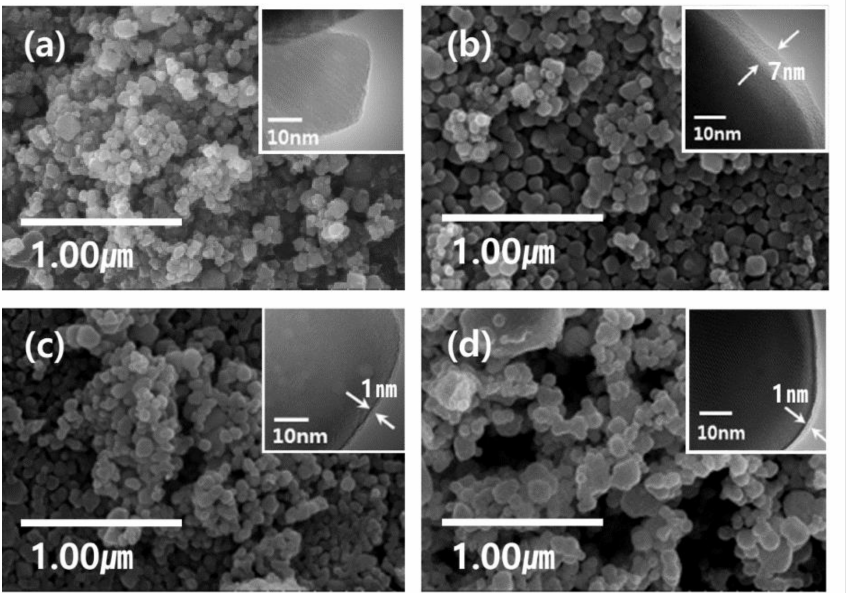
Figure 3. SEM and TEM images ( a ) Y 2 O 3 NP core sintered at 550°C for 3 h, ( b ) Eu-doped Y 2 O 3 NP active core with a passive Y 2 O 3 shell, ( c ) Tb-doped Y 2 O 3 NP active core with a passive Y 2 O 3 shell, ( d ) Dy-doped Y 2 O 3 NP active core with a passive Y 2 O 3 shell. The inset TEM images show the coating thickness of each